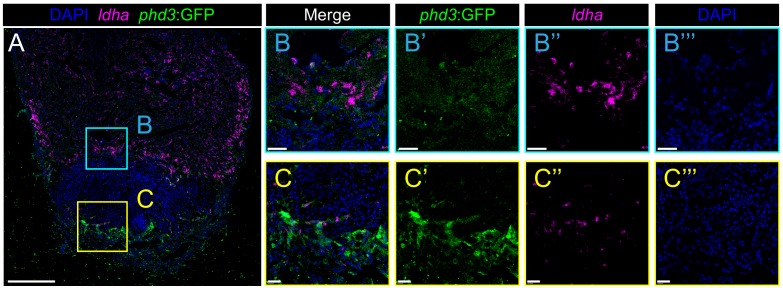
Hypoxia sensor phd3:GFP expression does not correlate with expression of the glycolytic gene ldha.(a) Overview picture of phd3:GFP heart 7dpi co-stained for expression of ldha by fluorescent ISH. (b) Zoom-ins of trabecular border zone cardiomyocytes. Note high ldha expression and low expression of phd3:GFP. (c) Zoom-ins of the apical region of the injury. Note the abundance of phd3:GFP signal in this region, while ldha expression is low.